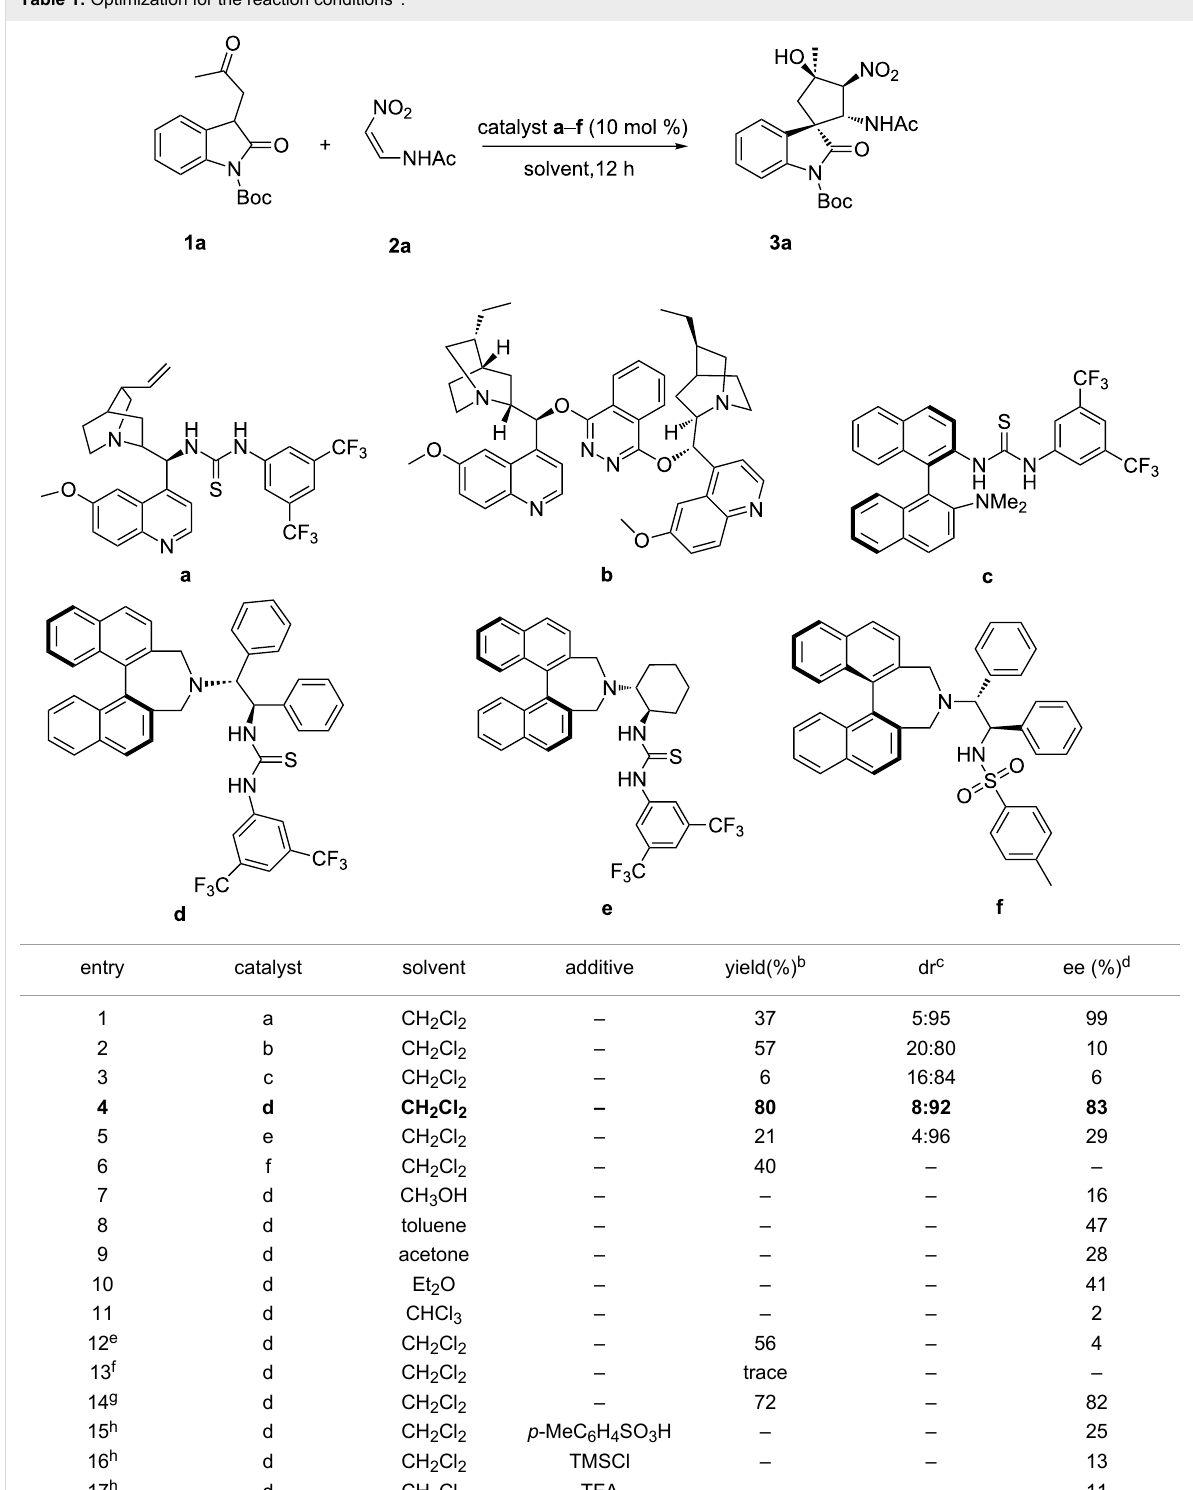
Table 1: Optimization for the reaction conditions a